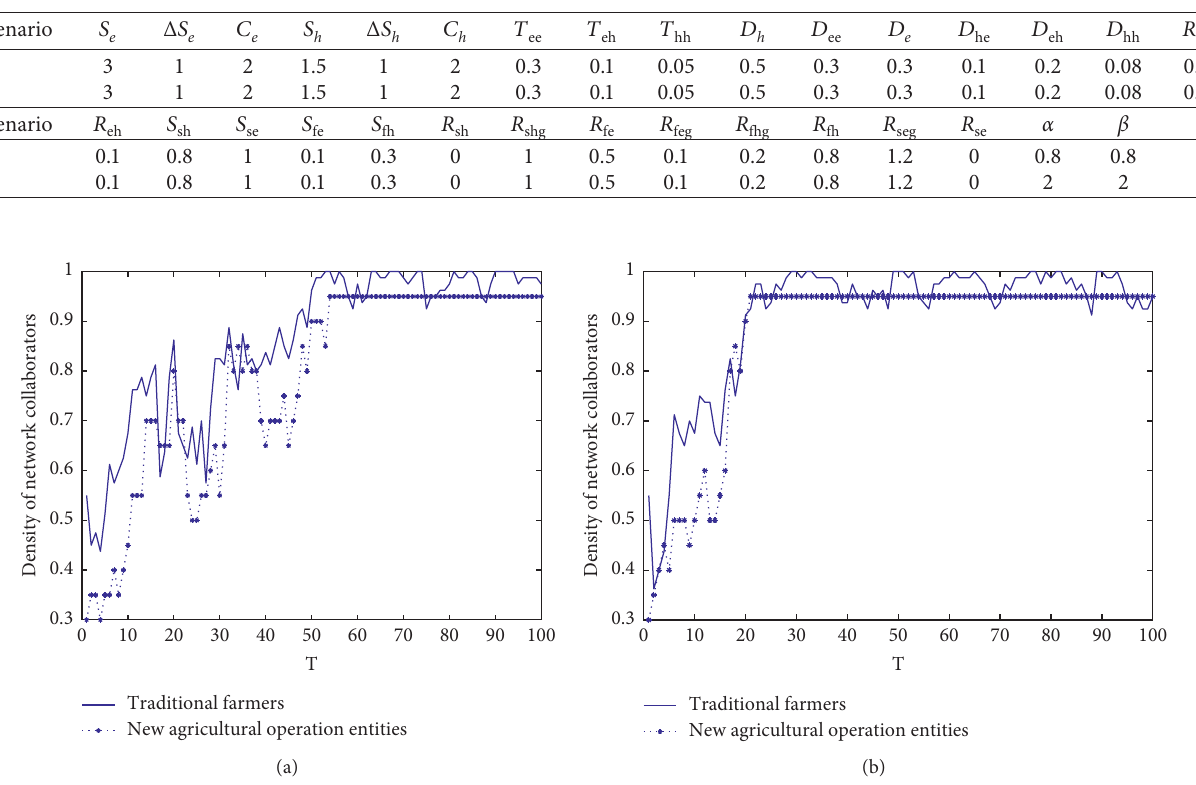
Table 8: Simulation parameter setting in different scenarios under government guidance